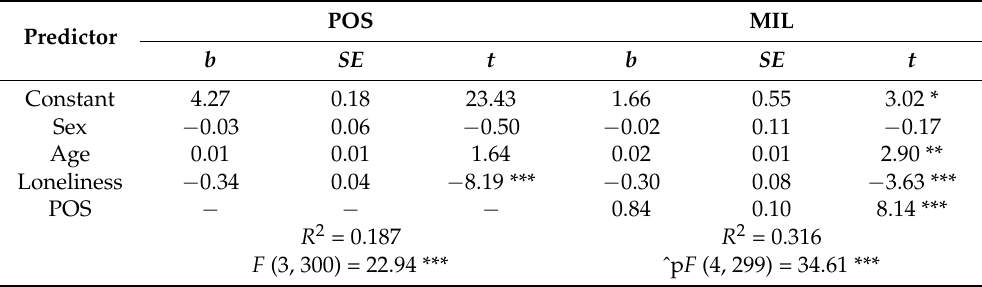
Table 2. Simple mediation